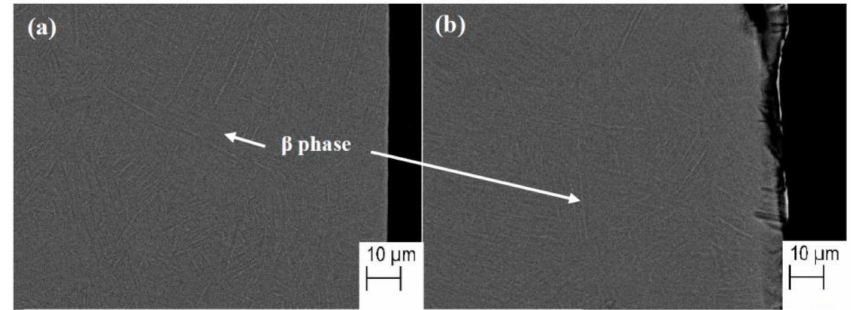
Figure 16. SEM micrographs of ( a ) UIT applied and ( b ) untreated specimens, BSE at 30